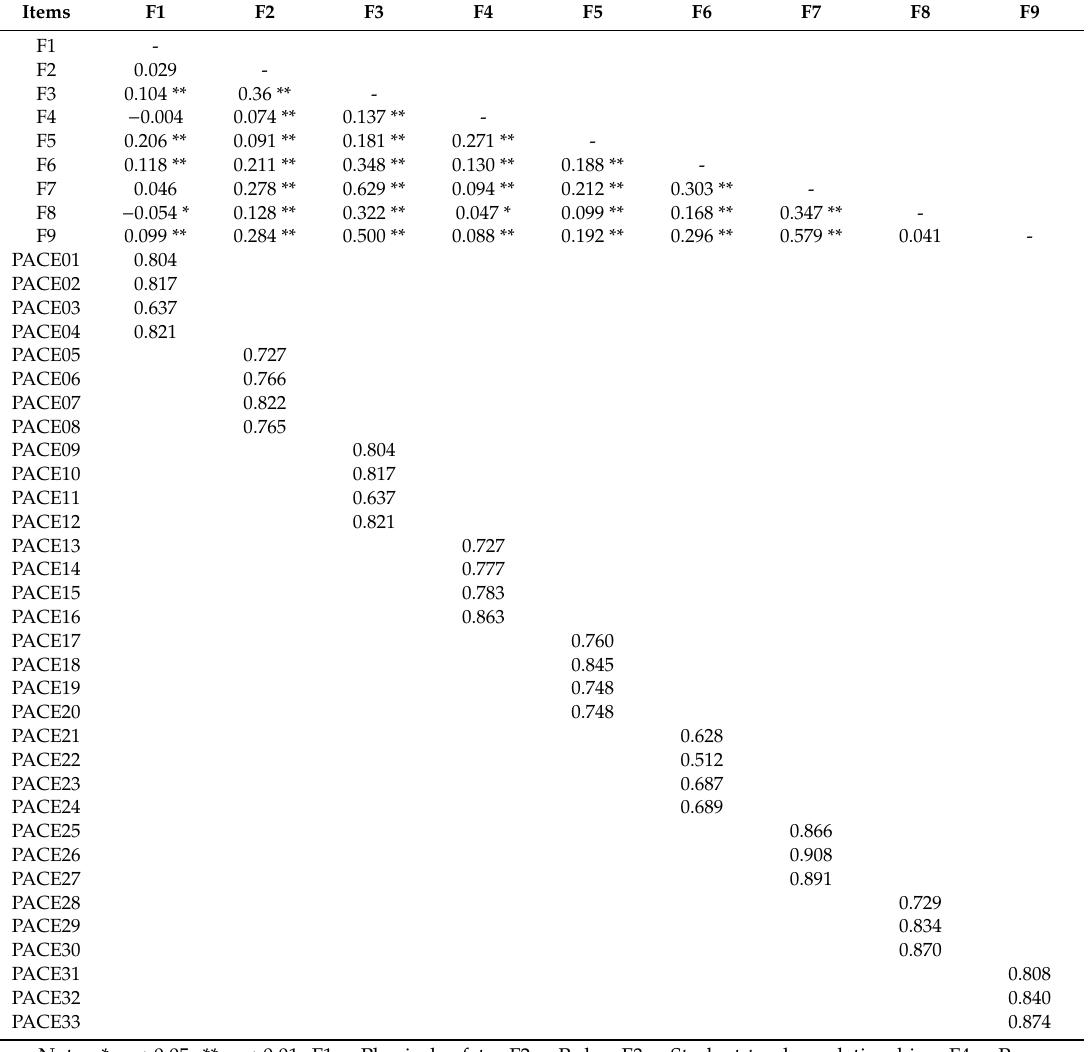
Table 3. Covariances between latent factors and item-factor regression coe ffi